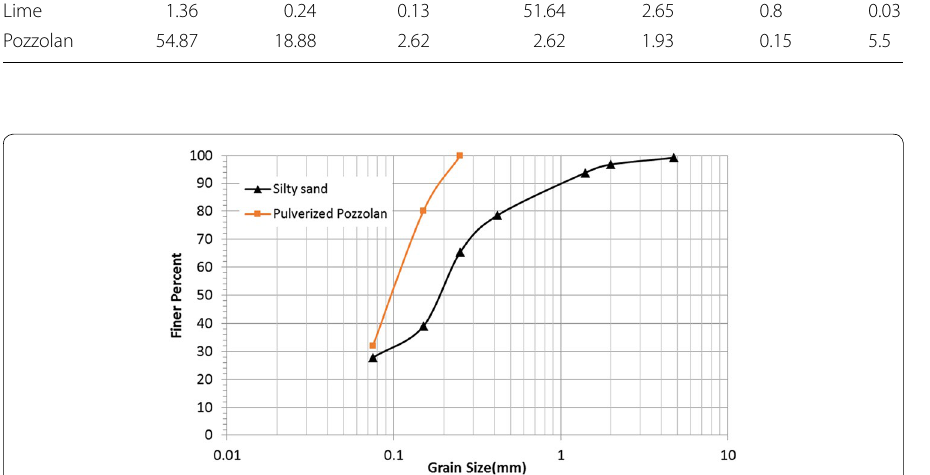
Fig. 1 The gradation curves of the studied